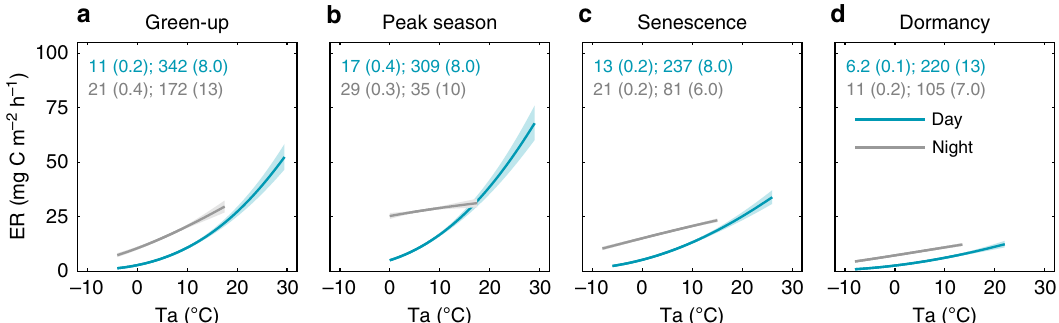
Fig. 3 Diel divergence in the temperature response of ecosystem respiration. Exponential regression relationships between ecosystem respiration (ER) measured by autochambers and air temperature (Ta) for day- and nighttime (i.e., photosynthetic photon fl ux density ≥ 20 and <20 μ mols m − 2 s − 1 , respectively) during the key phenophases of a green-up, b peak season, c senescence and d dormancy (spring and autumn) shown as a mean of the years 2015 – 2017 (see Supplementary Fig. 5 for results from individual years). Values shown in the panels (blue and gray for day- and nighttime periods, respectively) represent model parameters R 10 and E 0 with standard errors in brackets from the Lloyd & Taylor 14 respiration model (see equation in Methods). Solid lines indicate the exponential fi t and shaded bands indicate the 95% con fi dence